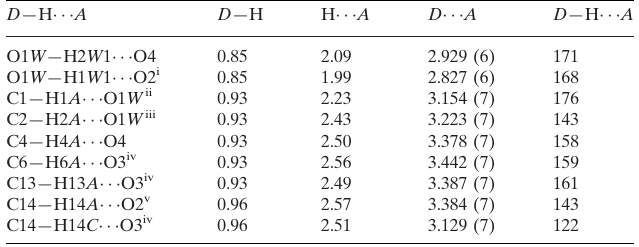
Hydrogen-bond geometry (A˚ , (cid:4)